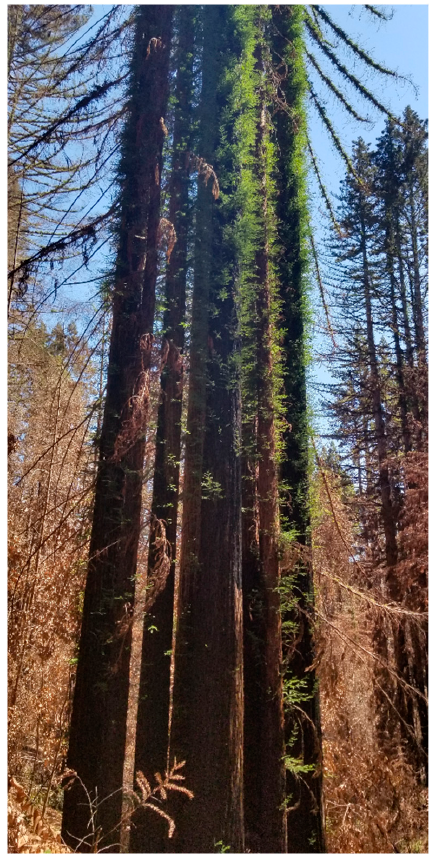
Figure 4. Epicormic sprouting in response to high severity crown fire on a group of Sequoia. Semper ‐ virens (D. Don) Endl . in Big Basin Redwoods State Park, California .